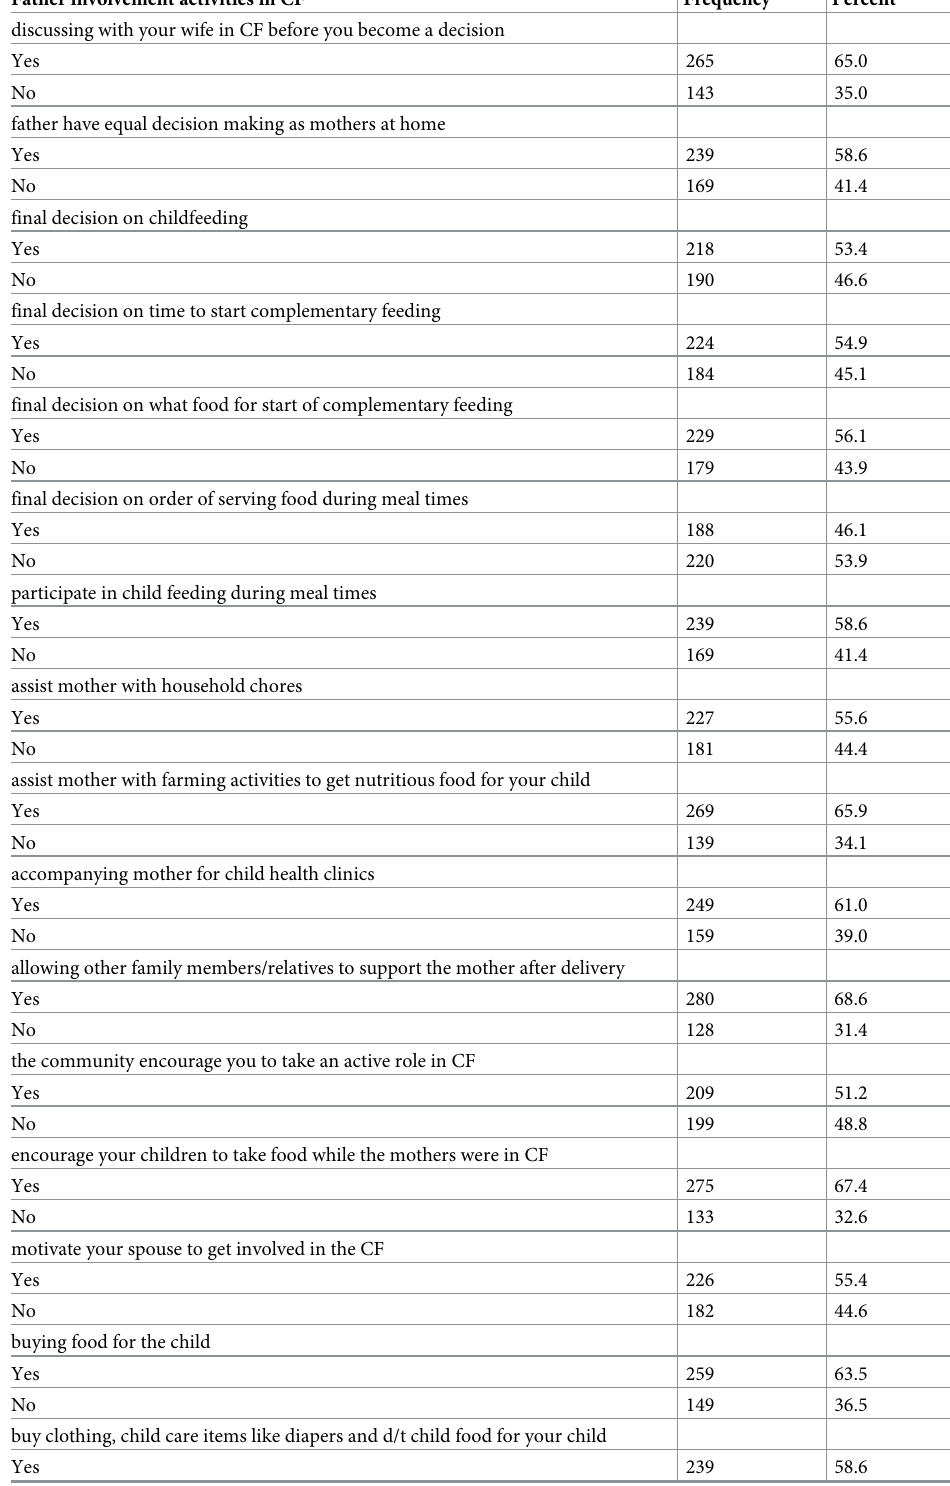
Table 5. Father involvement in child feeding in Antsokia Gemza Woreda,